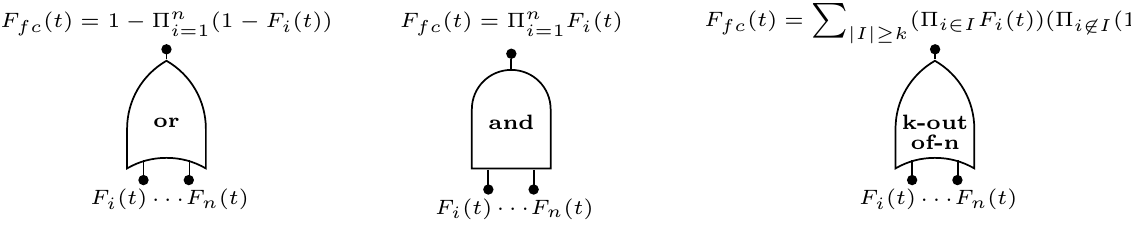
( t ) ) for the gate output ( and , or , k-out-of-n ). fc